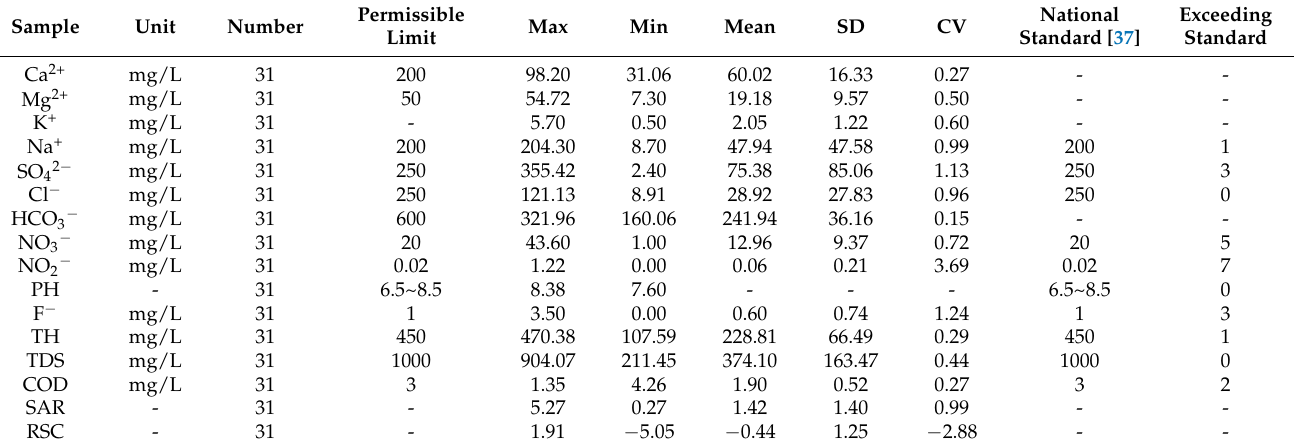
Table 4. The statistical data of hydrochemical parameters along with standard permissible limits for drink water in the study